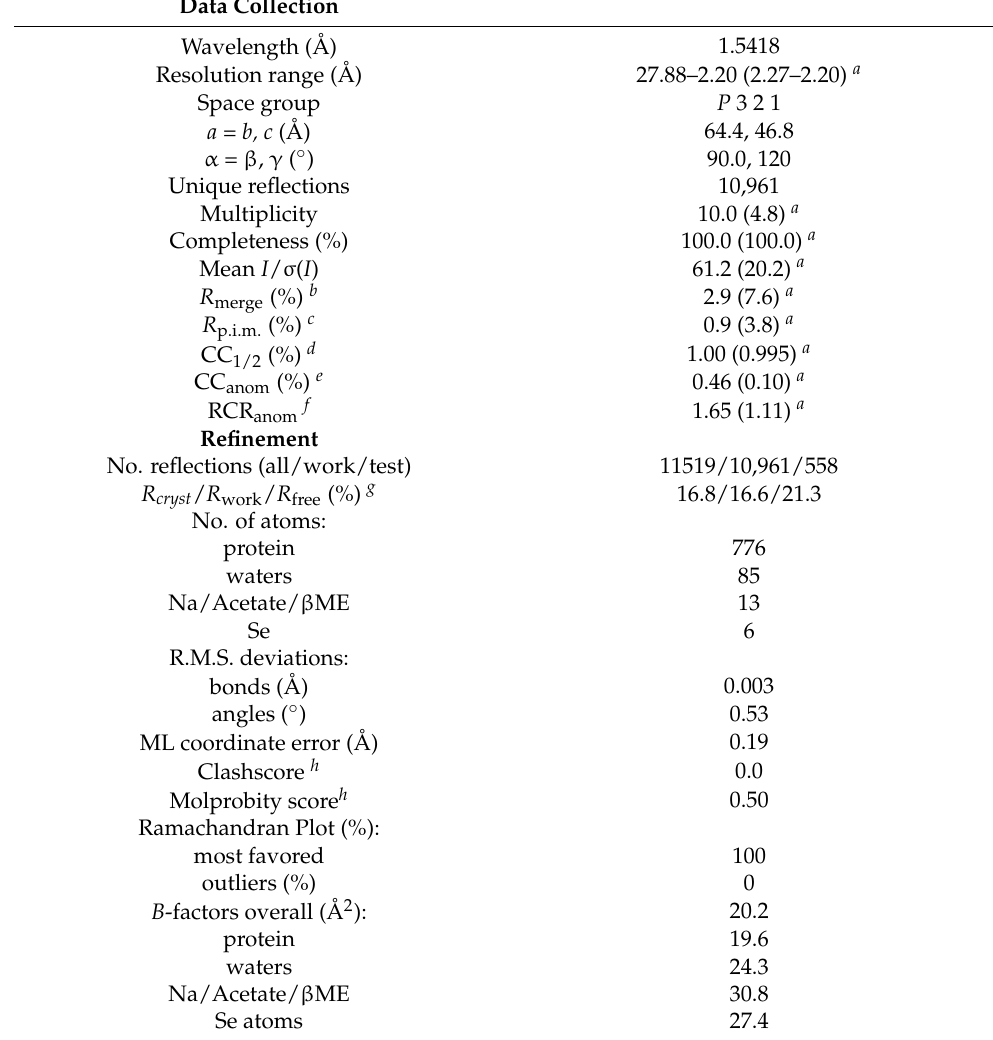
Table 3. Diffraction and refinement statistics of dmU1A(F37M/F77M)